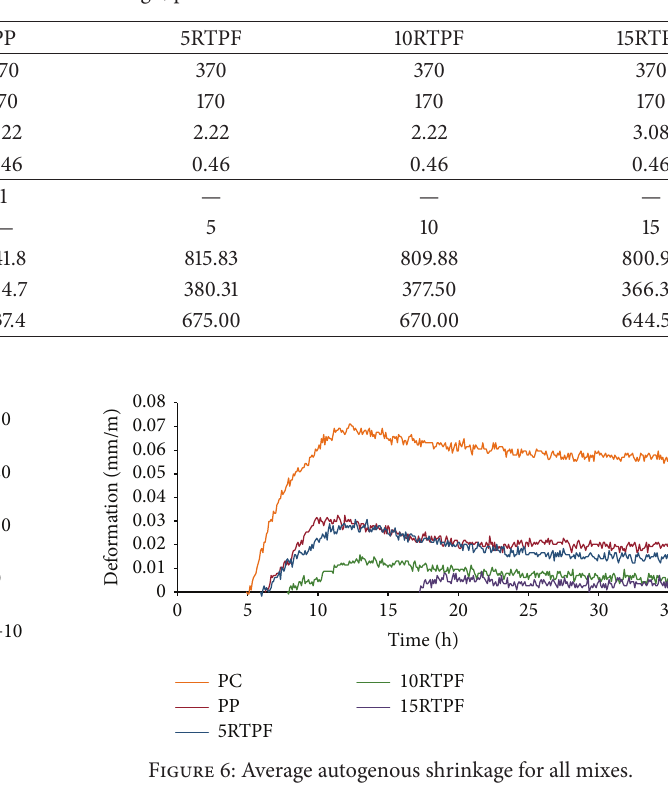
Figure 5: Average results of the autogenous shrinkage measure- ments starting from the appearance of swelling.